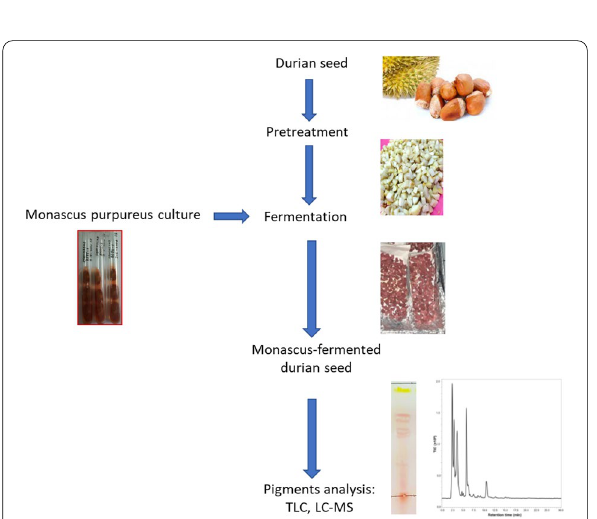
Fig. 2 Solid‑state fermentation of durian seed with Monascus purpureus for pigments